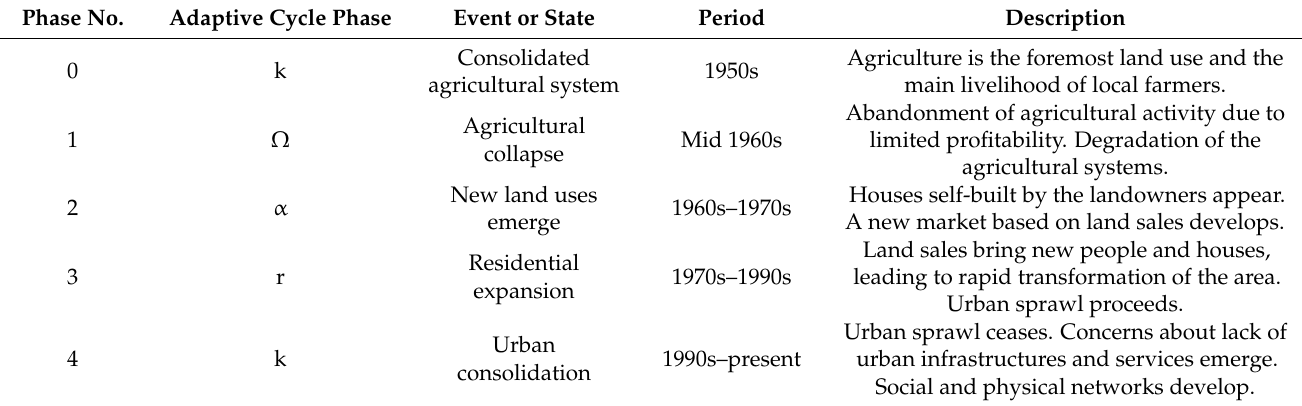
Table 1. Summary of the different phases of change identified in La Marjaleria and mapped on the adaptive cycle. Phase No.